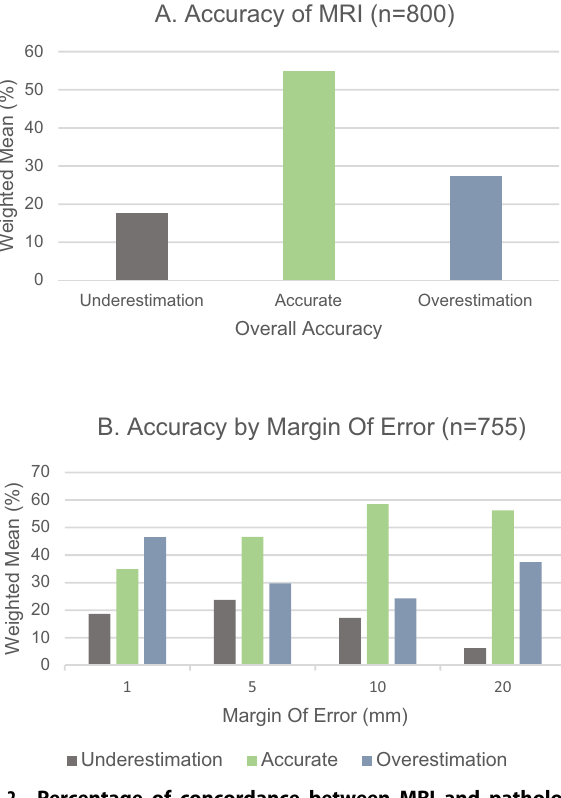
dispersion of the measurements, with greater concordance between MRI and pathology for tumours of smaller sizes. As the DCIS becomes larger, discordance between measurements increases progressively, without a clear tendency for over or underestimation 10,12 – 16 . Different plots are shown by Rahbar et al. (2015) and Pickles et al. (2015), which used a 3.0 T fi eld, instead of 1.5 T. In these plots, less dispersion is shown, with more consistent results regarding concordance of measurements for all tumour sizes 10,13 . Rahbar et al. (2015), also shows a narrower 95% LOA for a 3.0 T MRI, when compared to a 1.5 T, for the 19 tumours measured 10 . Of all the articles included, presented in Table 1, 13 presented accuracy percentages, but only 12 of these established a margin of error. A graphic summary of these results is presented in Fig. 2. With margins of error of 5 mm or more, with the exception of one study (Baur et al., 2013) 17 , we found there was a higher percentage of accurate measurements of tumour size by MRI. In pooled concordant results, 54.9% of the tumours were accurately measured by MRI, followed by a tendency for overestimation. Meta-analytic results of MRI accuracy in pathologic size estimation The low number of Bland – Altman analyses led us to use the difference between the means of tumour size for our meta- analysis. A total of 15 studies included in the fi nal analysis had random sets of data missing (Little, p = 0.434). Eight values for T a